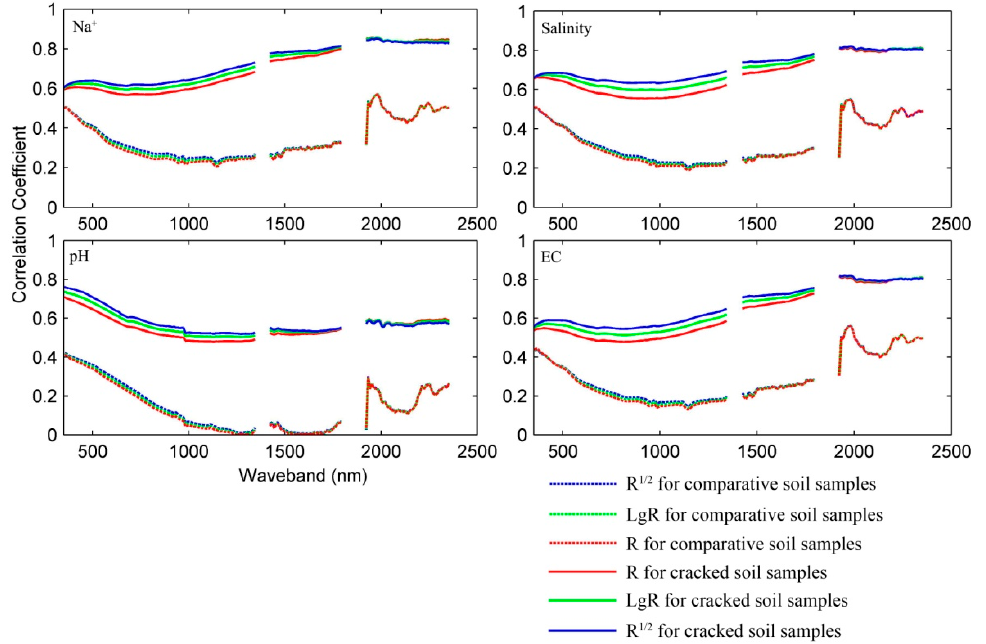
Figure 4. Correlograms between original spectral parameters and soil properties.